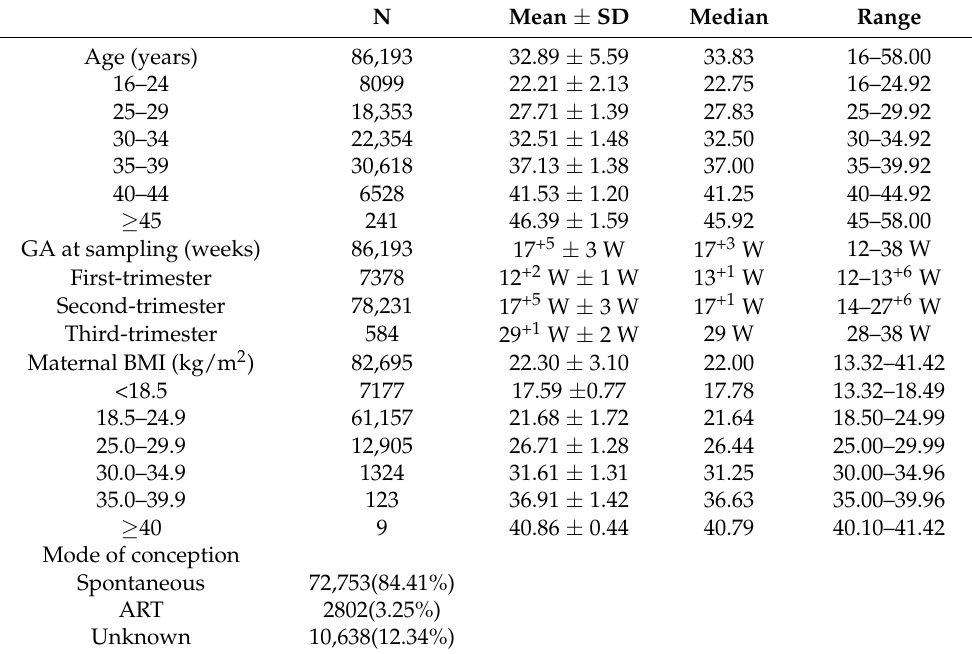
Table 1. Characteristics of the pregnant women with NIPS results in our